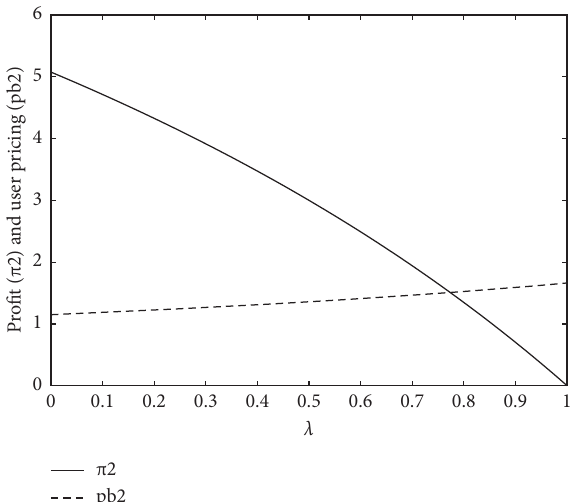
Figure 7: The impact of transaction share ratio on platform profit and user pricing.